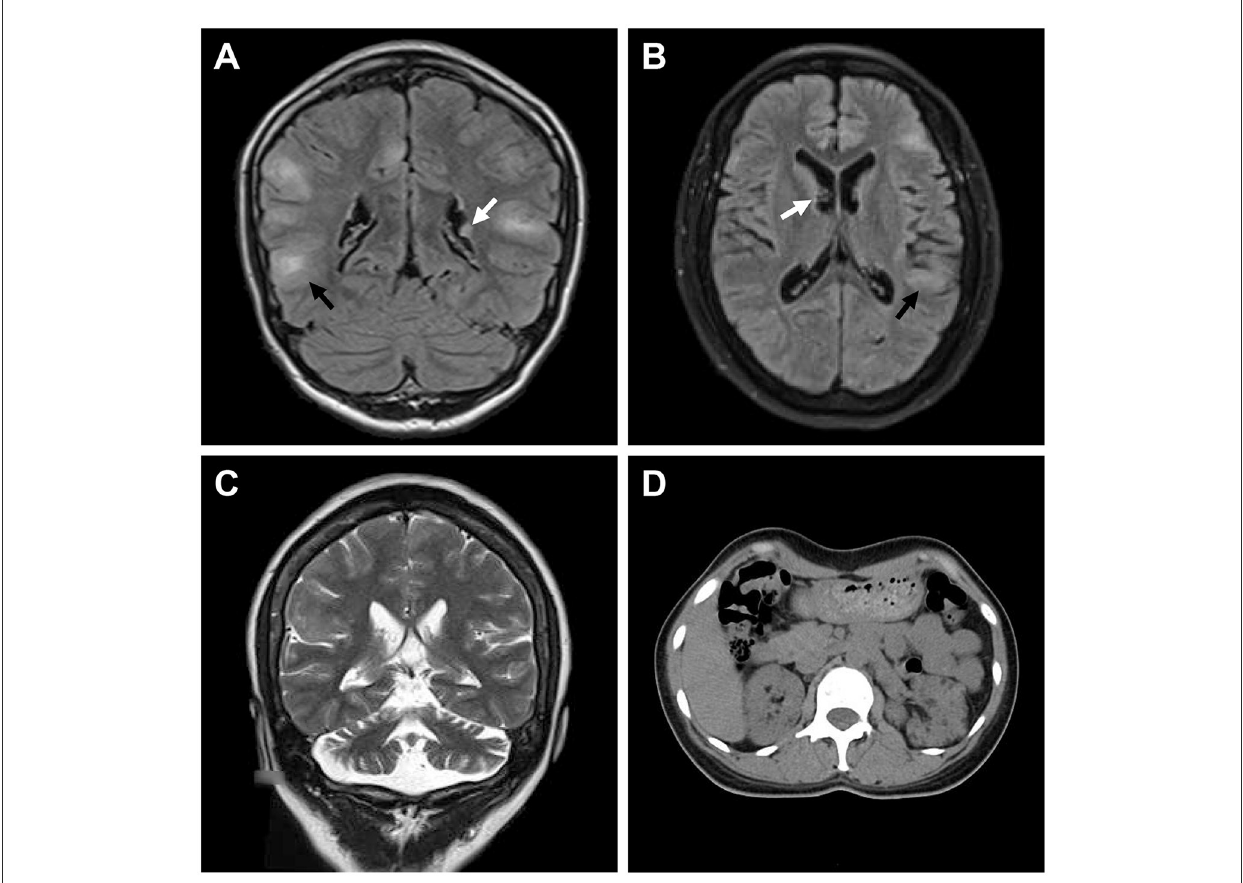
FIGURE2 Medical images of patients with TSC. (A) Water-suppressed T2-weighted MRI sequence of the proband and (B) water and fat-suppressed T2-weighted MRI sequence of patient II:2, showing cortical dysplasia (black arrow) and subependymal nodules (white arrow). (C) T2-weighted MRI sequence of patient II:2, showing cerebellar atrophy. (D) CT scan of patient II:2, showing renal angiomyolipomas and